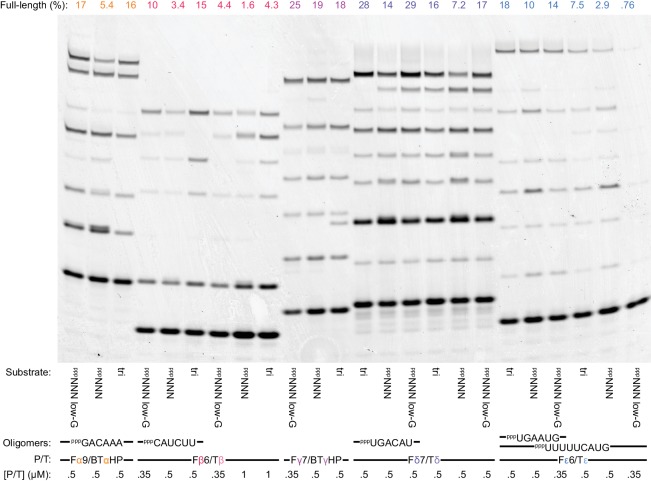
Ribozyme segment synthesis with random substrate pools.For maximum self-synthesis yield, we had used specific triplet substrate sets. Here we compare synthesis by 0.5 µM t5+1 of the five t5 ‘+’ segments (30 days in −7˚C ice) using specific triplets vs. random triplet pools or reduced G-content random triplet pools. Reactions included 5 µM of each triplet in specific triplet sets (‘tri’, as in Figure 6a ‘+’ syntheses), random pppNNN, or a low-G pppNNN. The low-G pppNNN had the same overall triplet concentration as pppNNN, but individual triplets were five-fold less common for each constituent G (~10/2/0.4/0.08 µM for 0/1/2/3 Gs per triplet; some primer/template (P/T) concentrations were reduced here to ensure excess substrate over template). Synthesis is compared with and without some longer oligonucleotide substrates (indicated below, equimolar to template sites, replacing the corresponding triplets in ‘tri’ substrate mixes). Importantly, for all ‘+’ strand segments, full-length products are generated using pppNNN with yields approaching those obtained when using specific triplets (calculated by densitometry, above the gel); intriguingly the low-G pppNNN pools often gave superior yields, possibly helped by the higher concentrations of weaker-binding AU-rich triplets therein.